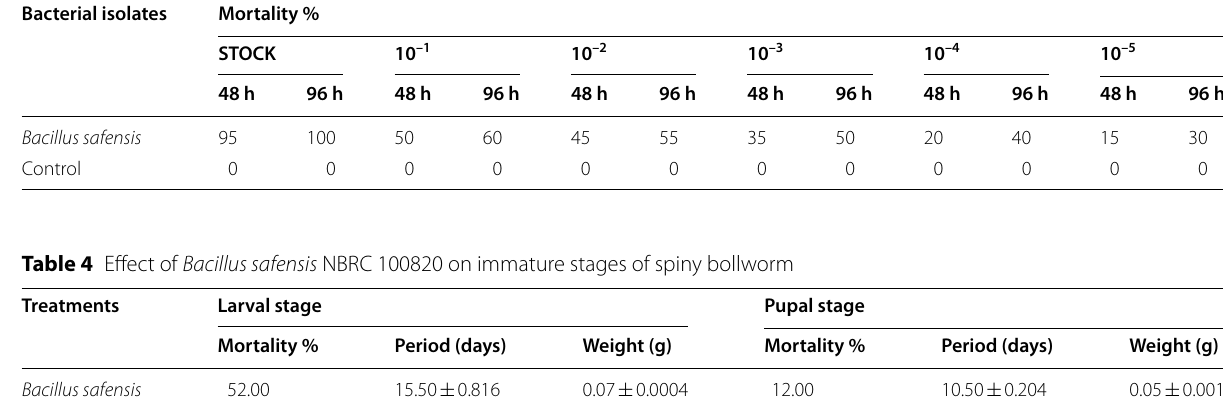
Table 3 Pathogenicity of tested Bacillus safensis NBRC 100820 concentrations on newly hatched the spiny bollworm larvae Bacterial isolates